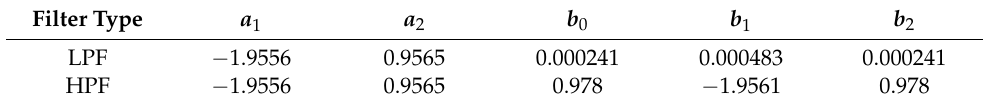
Table 1. Parameters of IIR low-pass and high-pass filters.